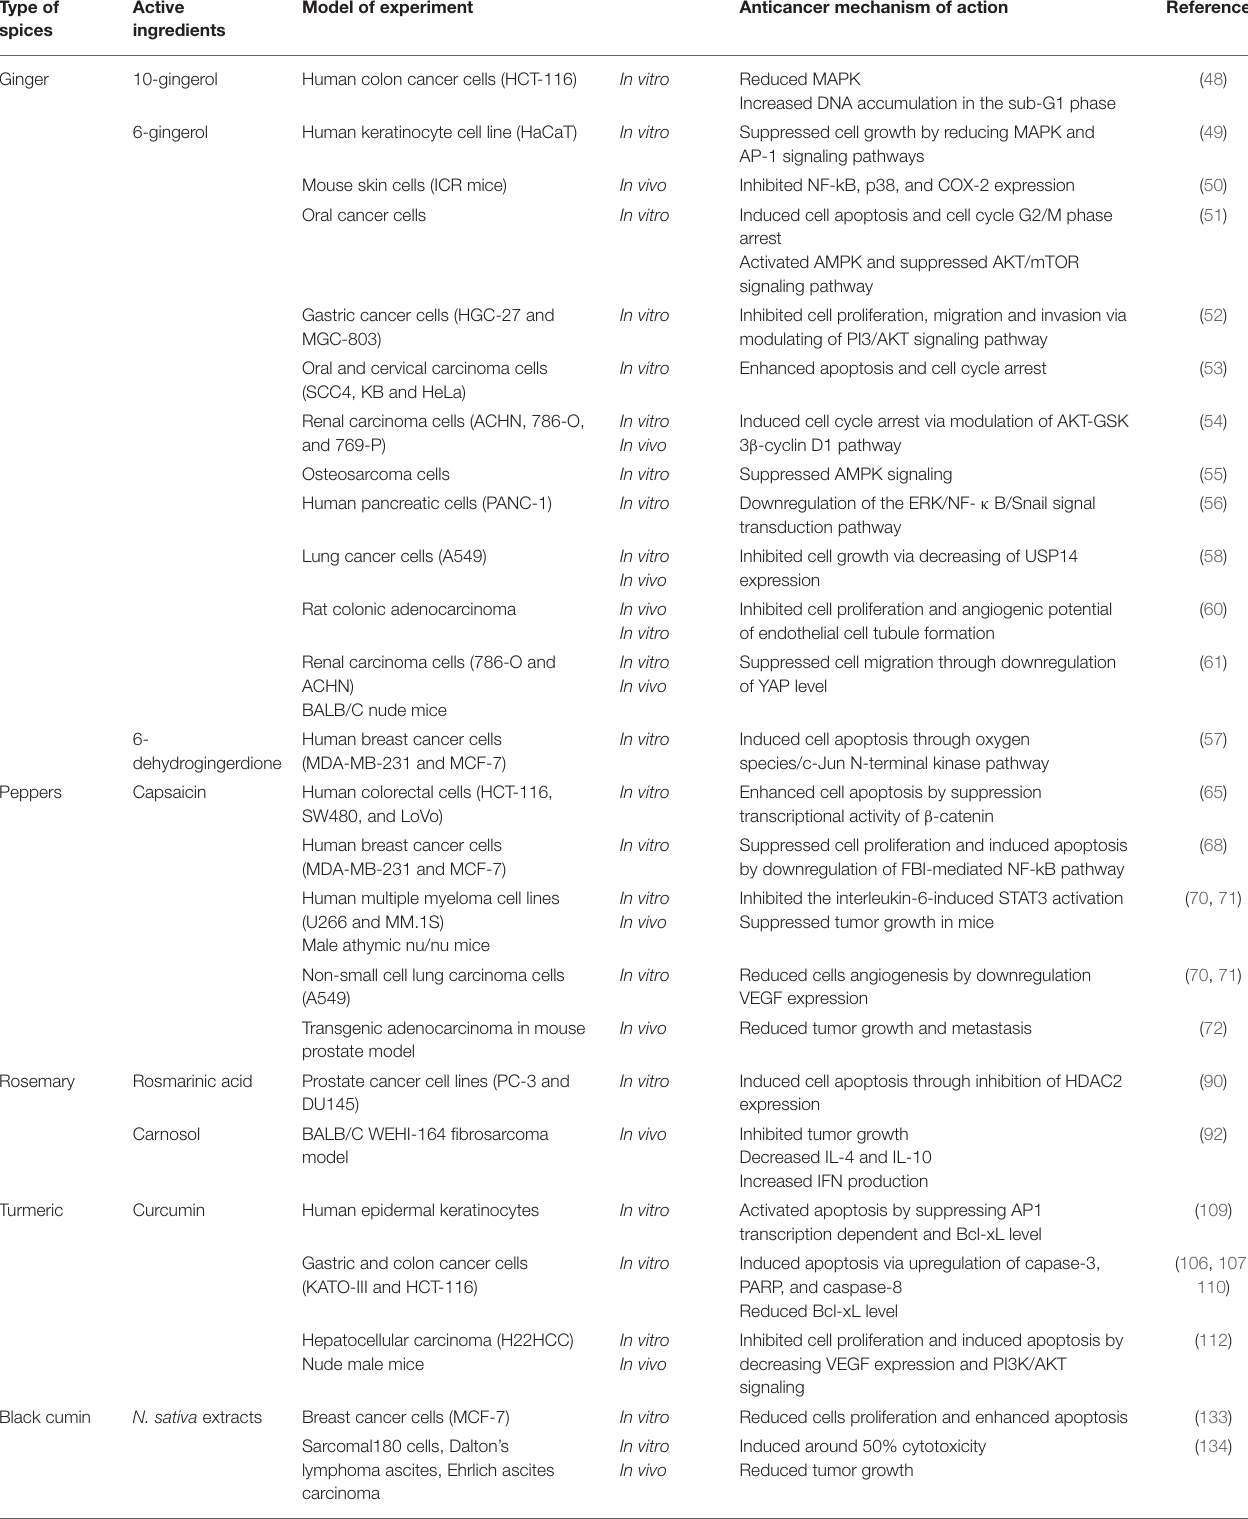
TABLE 2 | Anticancer activity of the main Mediterranean diet spices and their mechanisms of action. Type of